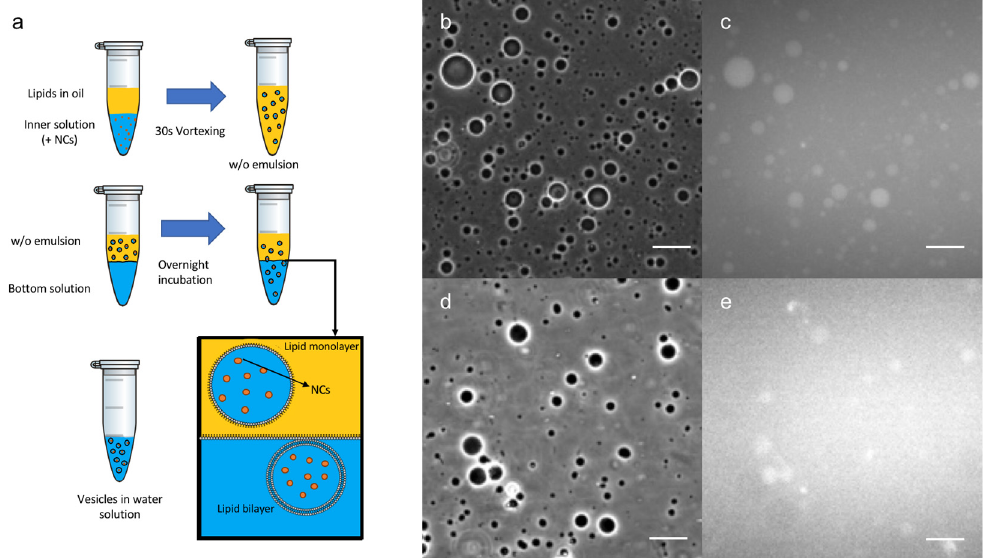
Figure 2. ( a ) Schematic view of Au NCs’ encapsulation method into GUVs. Optical microscope images in phase contrast ( b , d ) or luminescence ( c , e ) of: ( b , c ) C 3 E 6 D and ( d , e ) GSH Red NCs’ encapsulated into DOPC GUVs. Scale bar, 50 μ M.